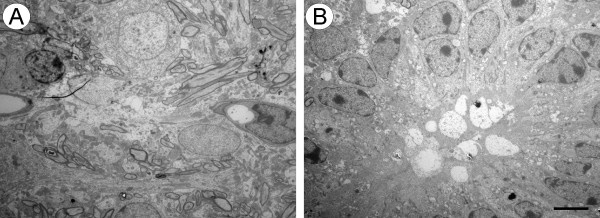
Electron micrograph showing two representative dying neurons in layer IX of spinal cord ventral horn of IFNγ-KO mice. (A) Dying neuron and the presence of glial cells in close contact with cell debris. (B) Many microglial cells ingesting a degenerating neuron. Scale bar: 5 μm.